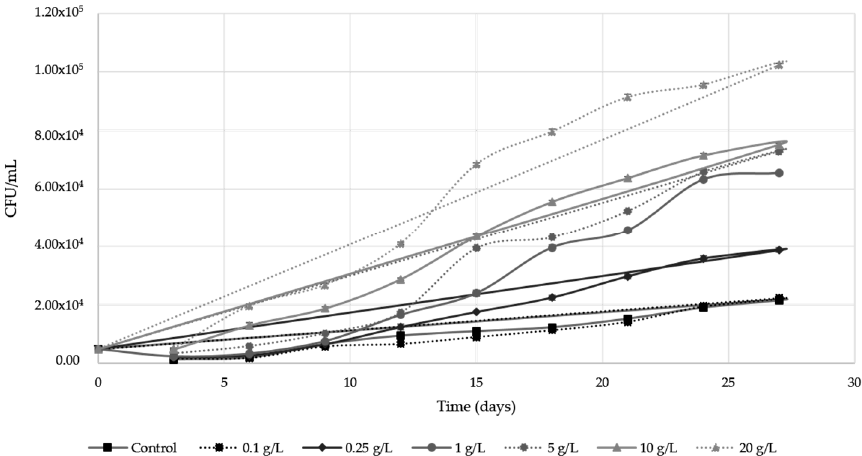
Figure 1. Evolution of the viable biomass of flor velum yeasts during the biological aging process of Palomino Fino wine with bee pollen doses. The results are the mean ± SD of three repetitions.